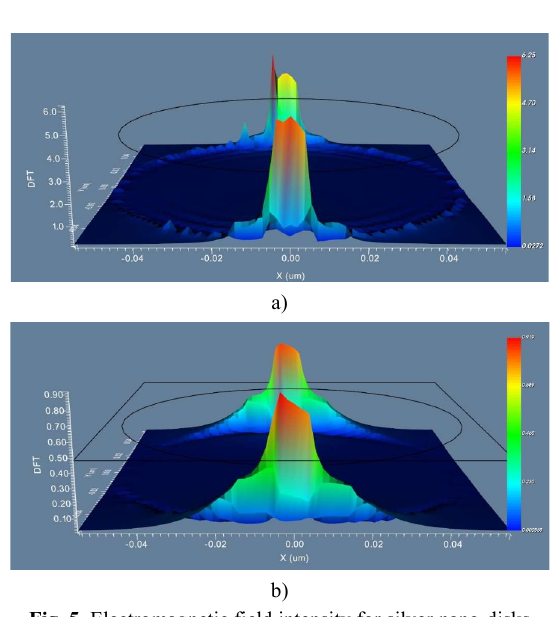
Fig. 5. Electromagnetic field intensity for silver nano-disks metasurface: a) interface medium/resonators; b) on the substrate around the resonator – 105 nm-diameter and 100 nm- high.